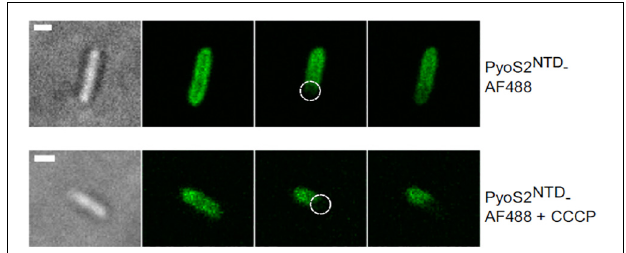
FIGURE 4 | FRAP experiments can be used to show that bacteriocin import is a PMF-dependent process. P. aeruginosa PAO1 cells are labeled with pyocin S2 AF488. The bleached region is highlighted (dashed circle). FRAP suggests pyoS2NTD-AF488 has translocated to the periplasm, where it can diffuse laterally. Absence of FRAP observed when cells are treated with 100 µ M CCCP indicates that the pyocin remains bound to FpvAI in the OM and that the PMF is necessary for pyocin translocation. Scale bars, 1 µ m [image taken and used with permission from White et al. (2017), CC BY-NC-ND 4.0].